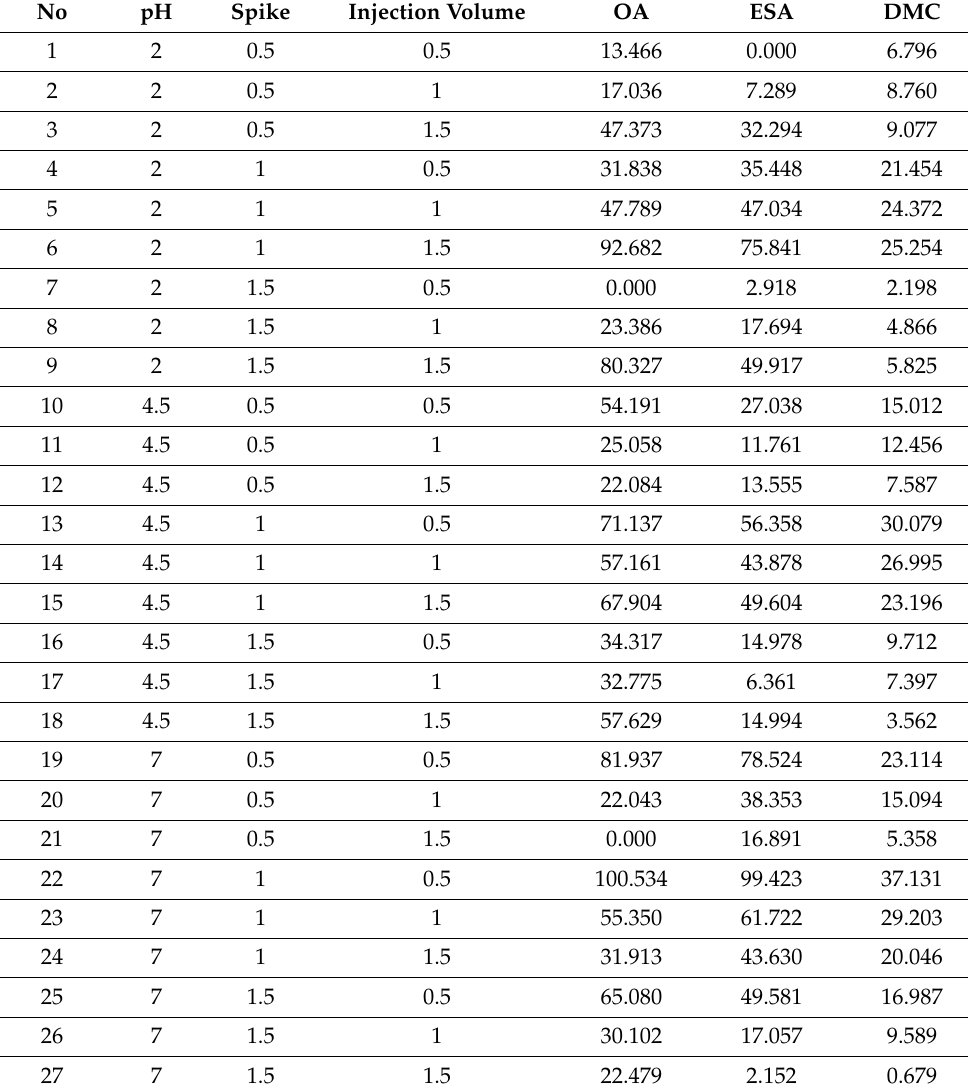
Table 2. The full factorial experimental design used for model